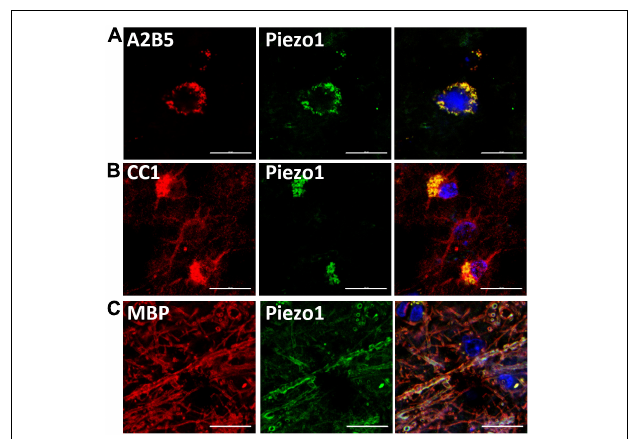
FIGURE 1 | Piezo1 is expressed in oligodendrocyte linage cells in the human brain. (A) Piezo1 protein is present in OPCs (A2B5 + ), (B) in oligodendrocyte cell bodies (CC1 + ) and in (C) myelin (MBP + ), as indicated by overlapping green (Piezo1) and red staining. Representative images of N = 3 human brains. Scale 20 µ